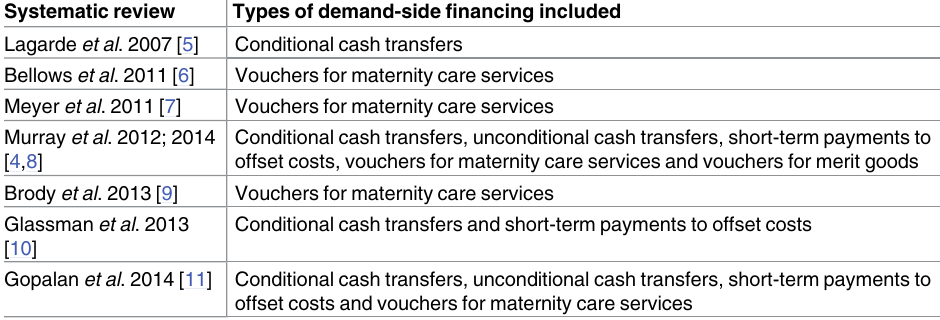
Table 1. Systematic reviews of demand-side